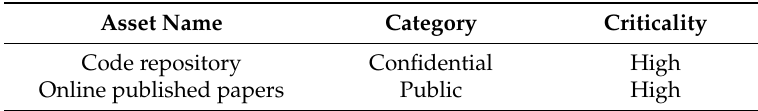
Table 1. Asset categorisation and